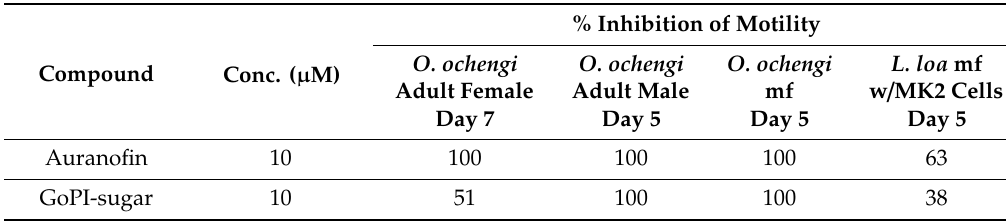
Table 5. Comparison of the motility inhibition of auranofin and GoPI-sugar against O . ochengi adults and microfilariae (mf) and L . loa